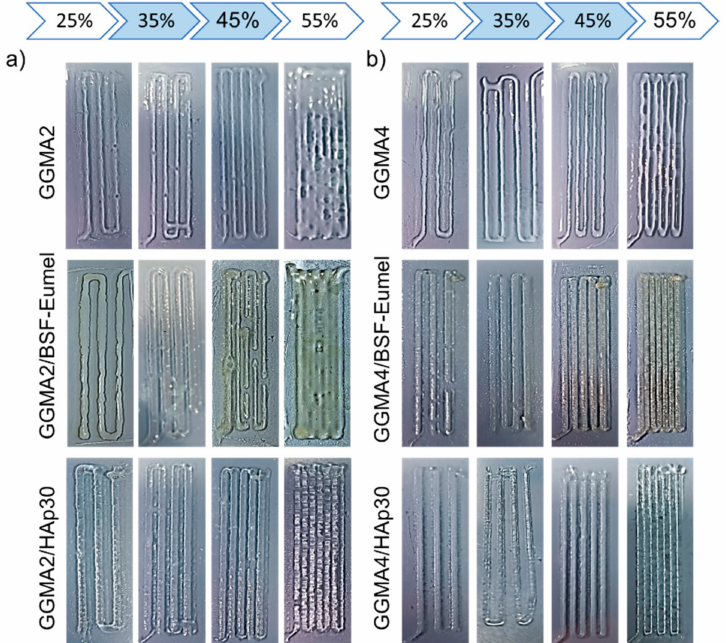
Figure 3. Filament fusion test performed on ( a ) GGMA2-based and ( b ) GGMA4-based ink formula- tions, by varying the percentage infill from 25 to